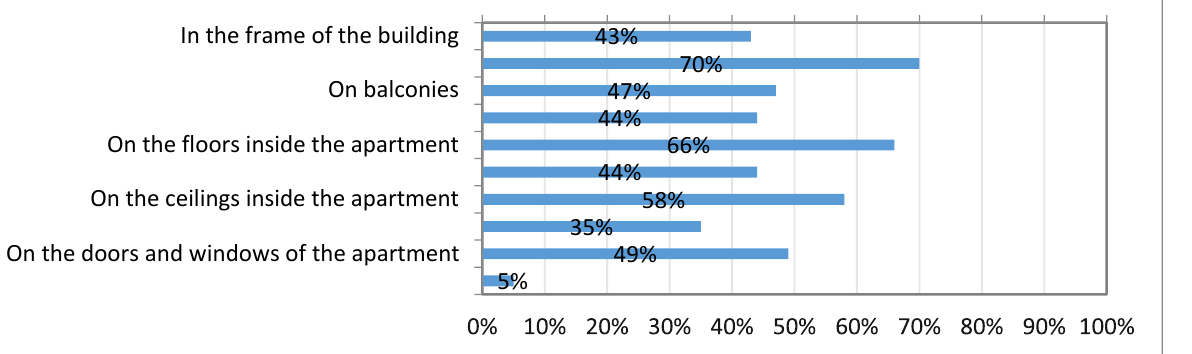
Figure 19. The places where the use of wood is most desired.